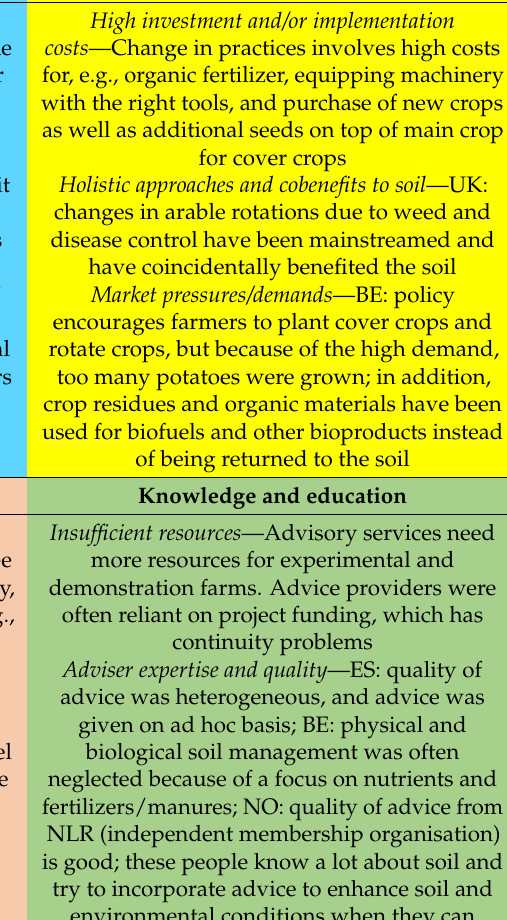
Table 3. Adoption factors in SoilCare study sites. Sociocultural